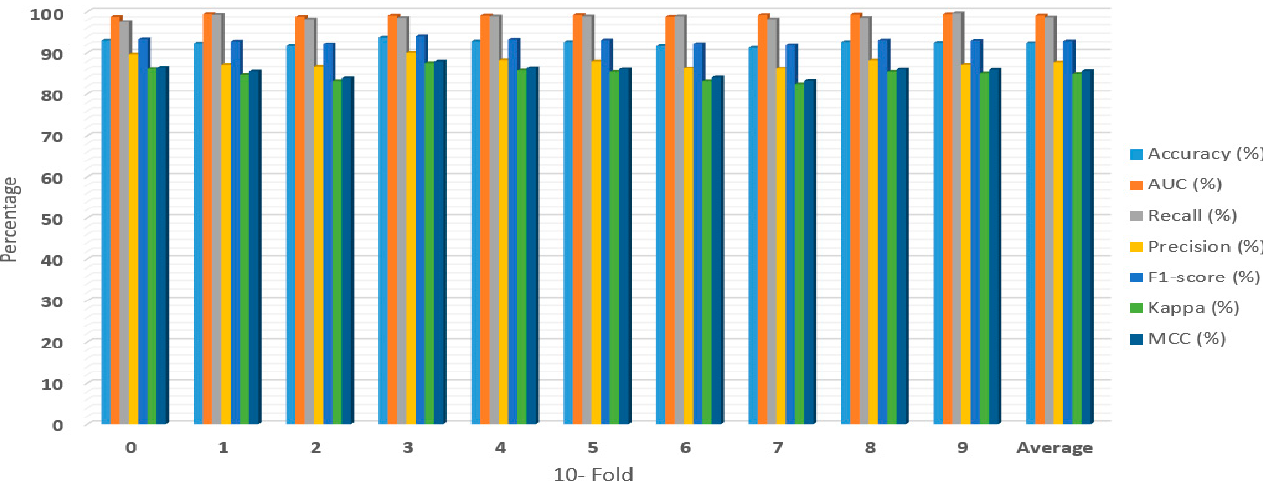
Figure 7. The metrics of the XGBoost model after tuning the hyper-parameters.